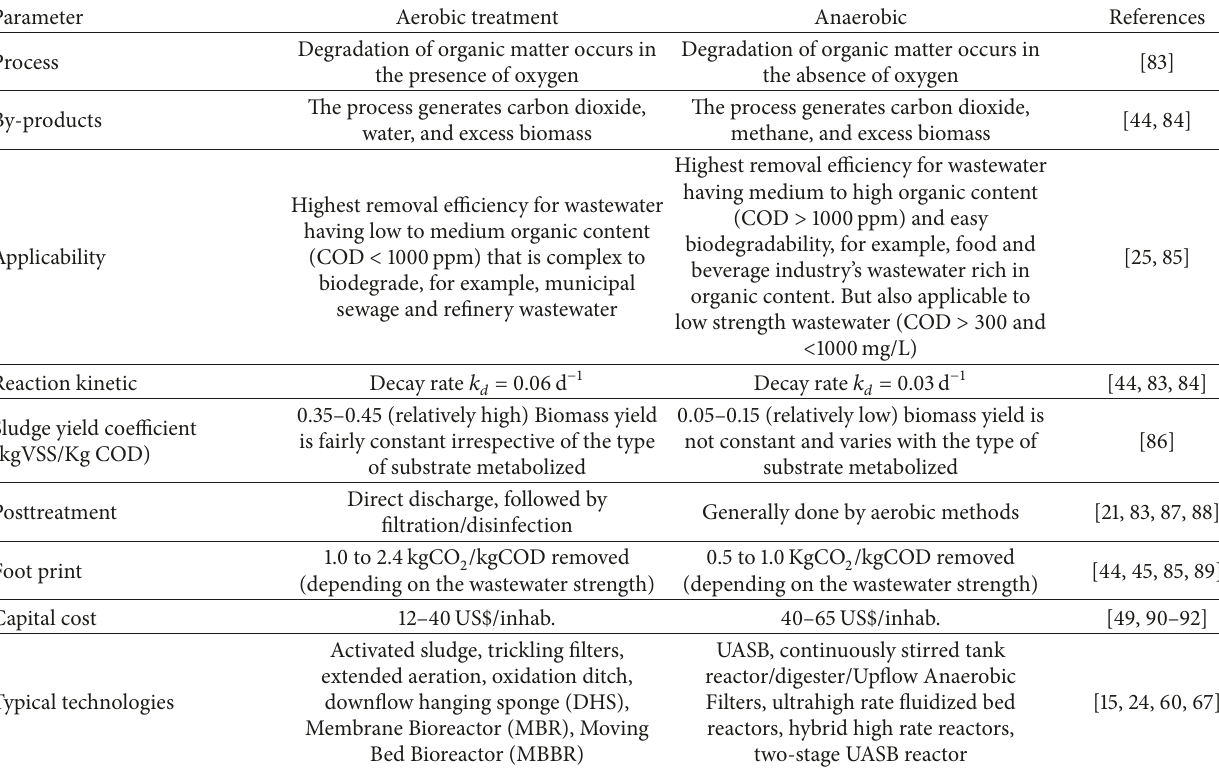
Table 2: Comparison of aerobic and anaerobic treatment